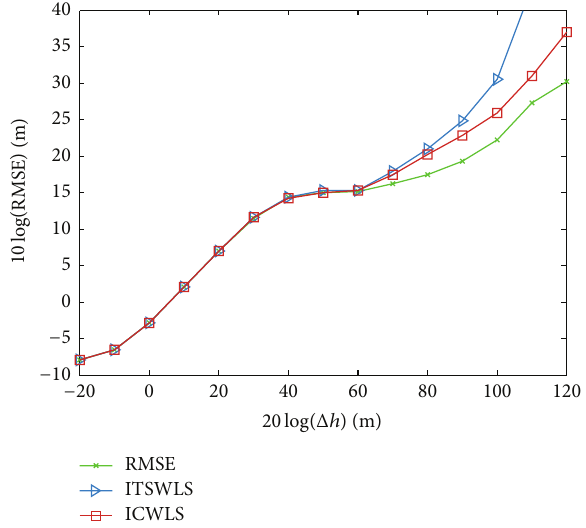
Figure 5: Comparison of target geolocation RMSEs of ITSWLS and ICWLS as a function of Δℎ